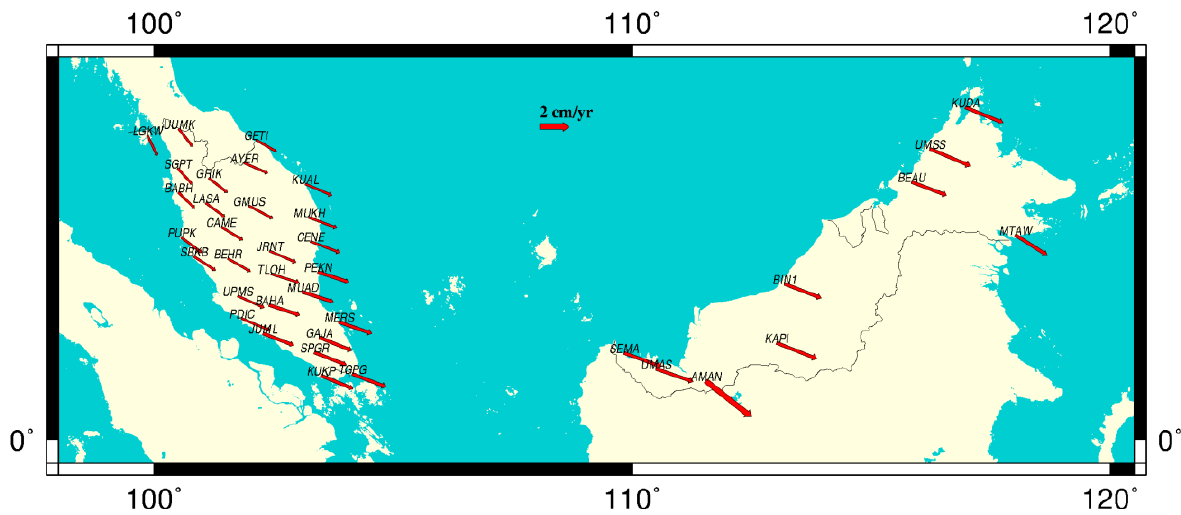
Figure 6. MyRTKnet velocity vector map for years 2008 to 2011. Note that fewer stations are displayed as the station names and arrows will overlap one another. As for East Malaysia, most stations began operation in April 2009; hence, they are not selected for velocity vector